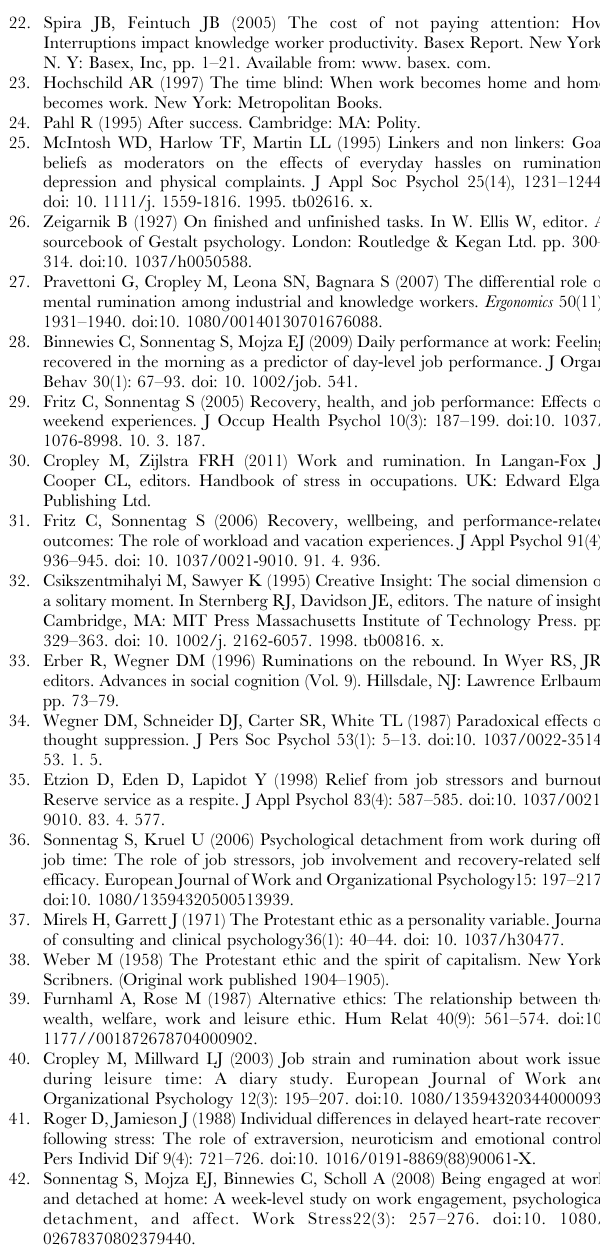
Table S5 Results of regression analysis of positive interruption and work beliefs on three types of work rumination. Table S6 Results of regression analysis of positive interruption and work beliefs on three types of work